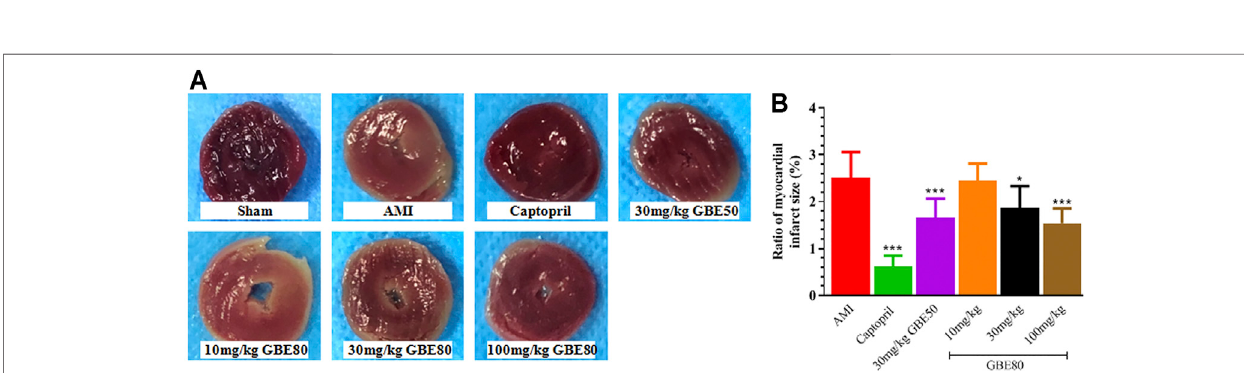
related proteins. The levels of GSK3 β , AKT, and β -catenin in the model group were reduced signi fi cantly compared with those in the sham group, which con fi rmed that AKT/GSK3 β / β -catenin signaling was affected by AMI injury ( Figure 5A ). GBE80 treatment resulted in